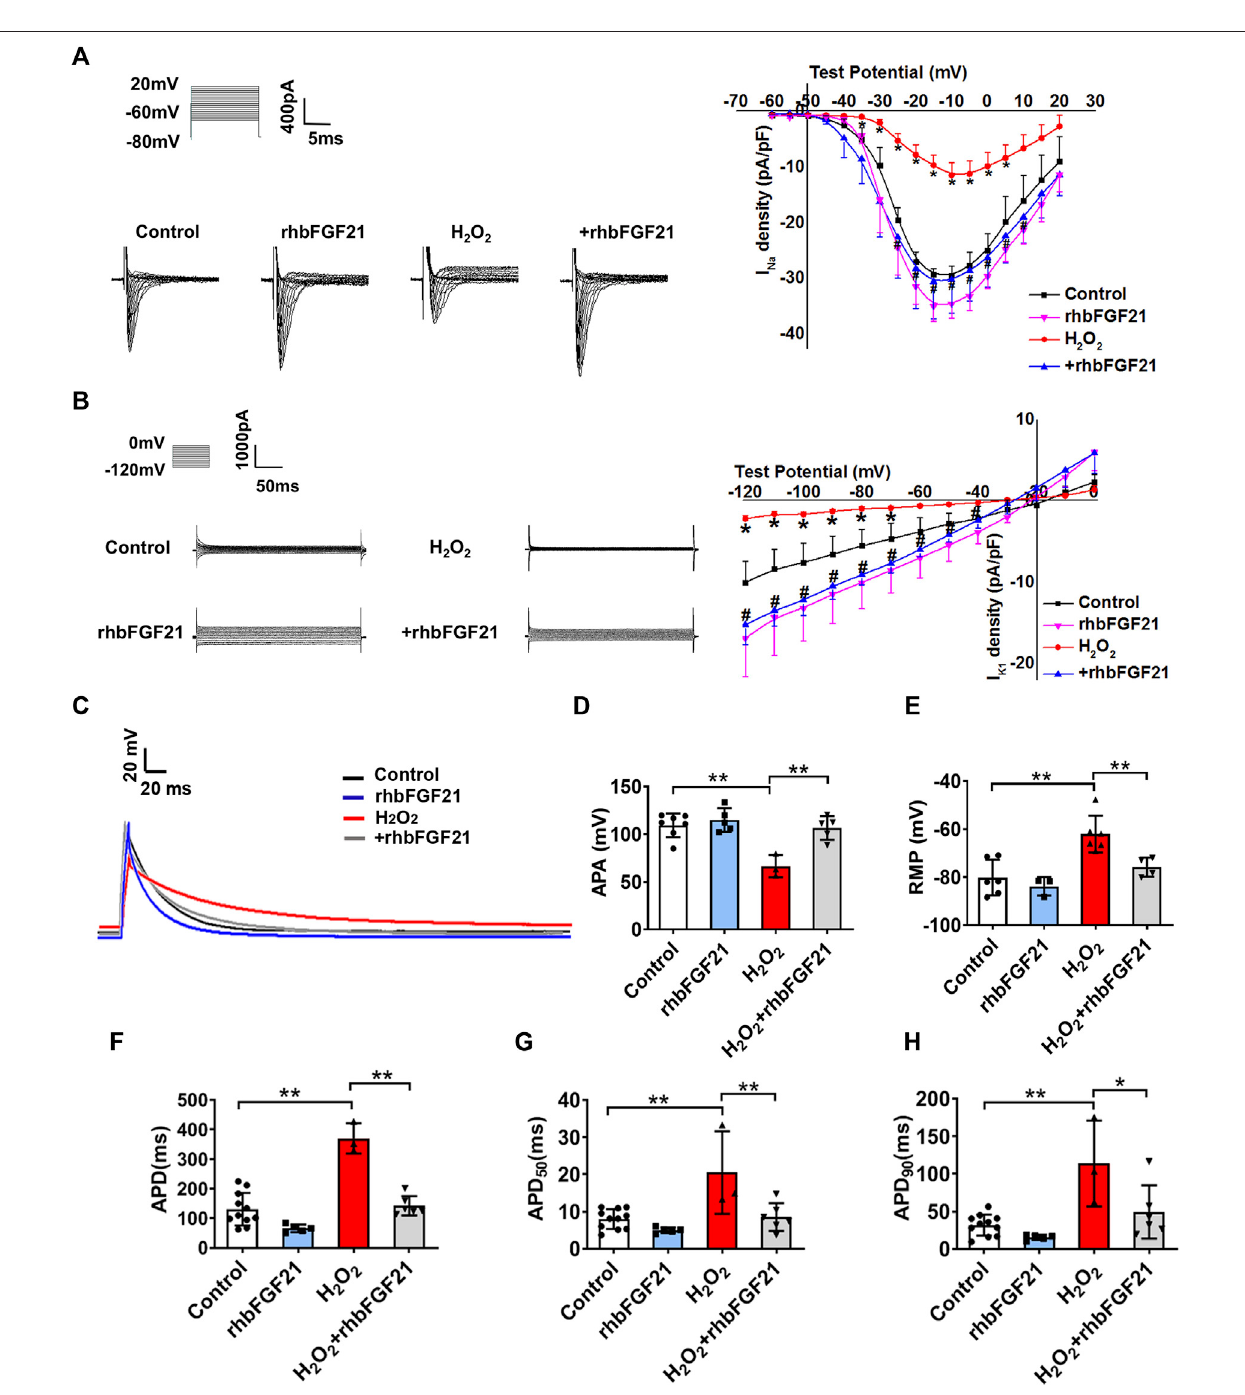
FIGURE 2 | Effects of FGF21 on Na + channel ( I Na ) and K + channel ( I K1 ) currents of AC16 human cardiomyocytes. (A, B) The current density-voltage relationships curves of whole-cell sodium current ( I Na ) and potassium current ( I K1 ) were recorded in AC16 cells treatment with H 2 O 2 and H 2 O 2 +rhbFGF21. * p < 0.05 vs. Control. (C) Exemplar superimposed traces of APD recorded from myocytes, and comparison of average data of APD (F) , APD 50 (G) , and APD 90 (H) measured AC16 human cardiomyocytes from Control, rhbFGF21, H 2 O 2 , and H 2 O 2 +rhbFGF21. One-way ANOVA with Tukey ’ s multiple comparisons test was used to compare the difference betweenmultiple groups, * p < 0.05; ** p < 0.01. (D,E) TheAPAand RMPofAC16 cellsfrom Control, rhbFGF21, H 2 O 2 , andH 2 O 2 +rhbFGF21grouprecorded by patch-clamp technique. n (cid:1) 3 – 7, ** p < 0.01.